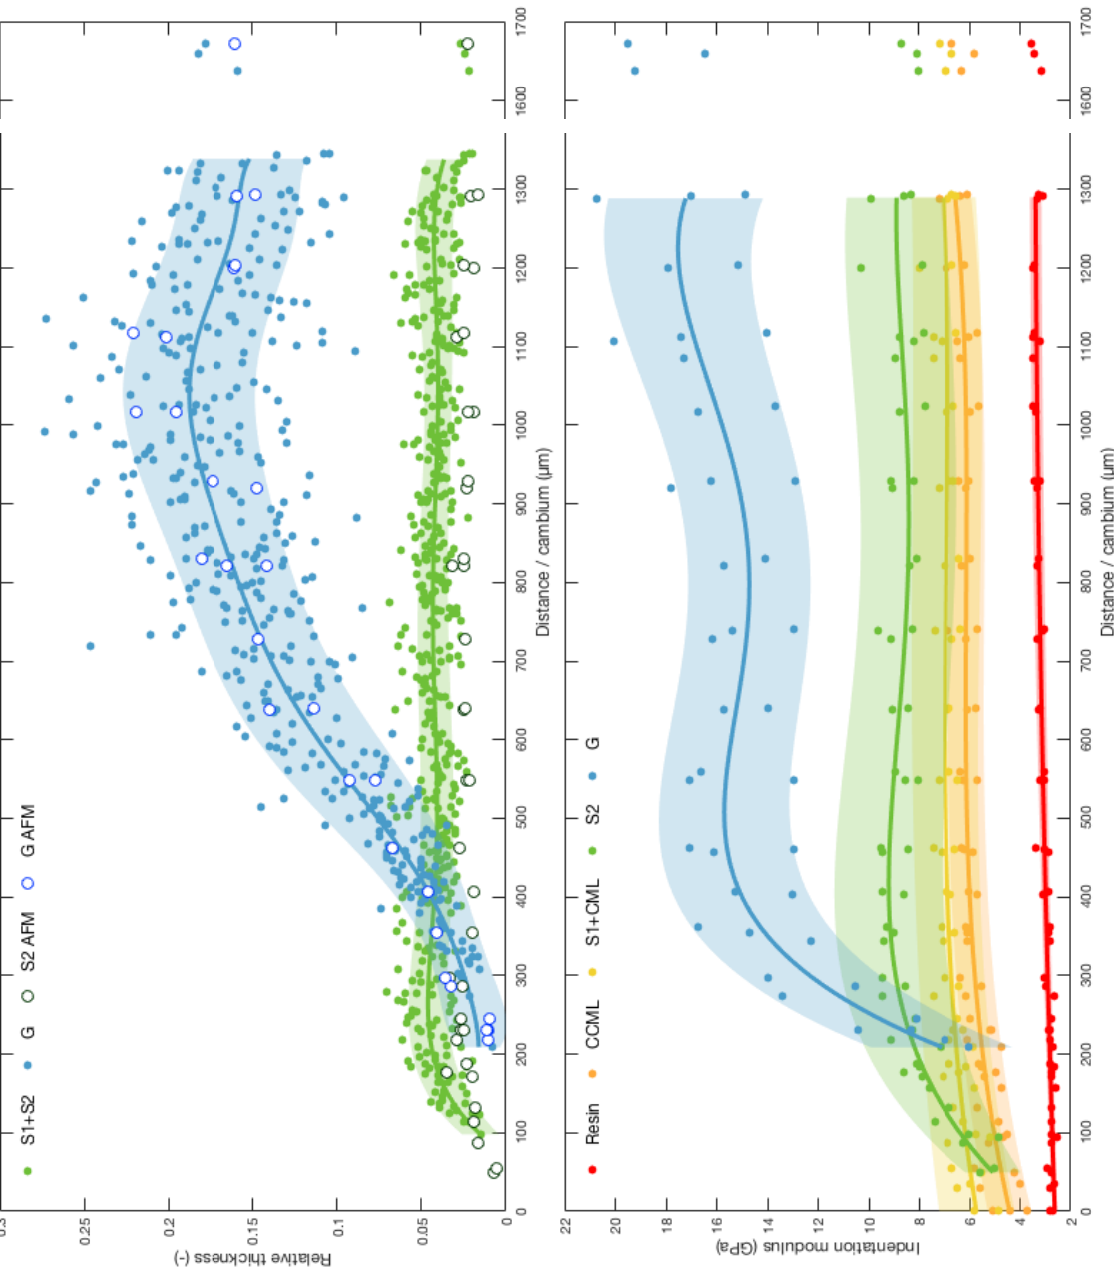
Figure 6 : Variations in the relative thickness of the cell wall layers measured by optical microscopy (coloured dots) and AFM (empty circles) (top) and mode of the indentation modulus distribution (bottom), as a function of the distance from the cambium. The solid lines and the shaded areas show the mean tendency and standard deviation adjusted on these